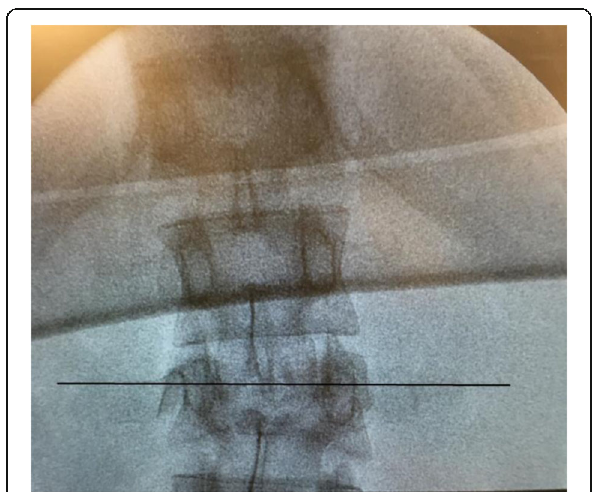
Fig. 2 A guidewire placed on the back of the patient perpendicular to the axis of the spine